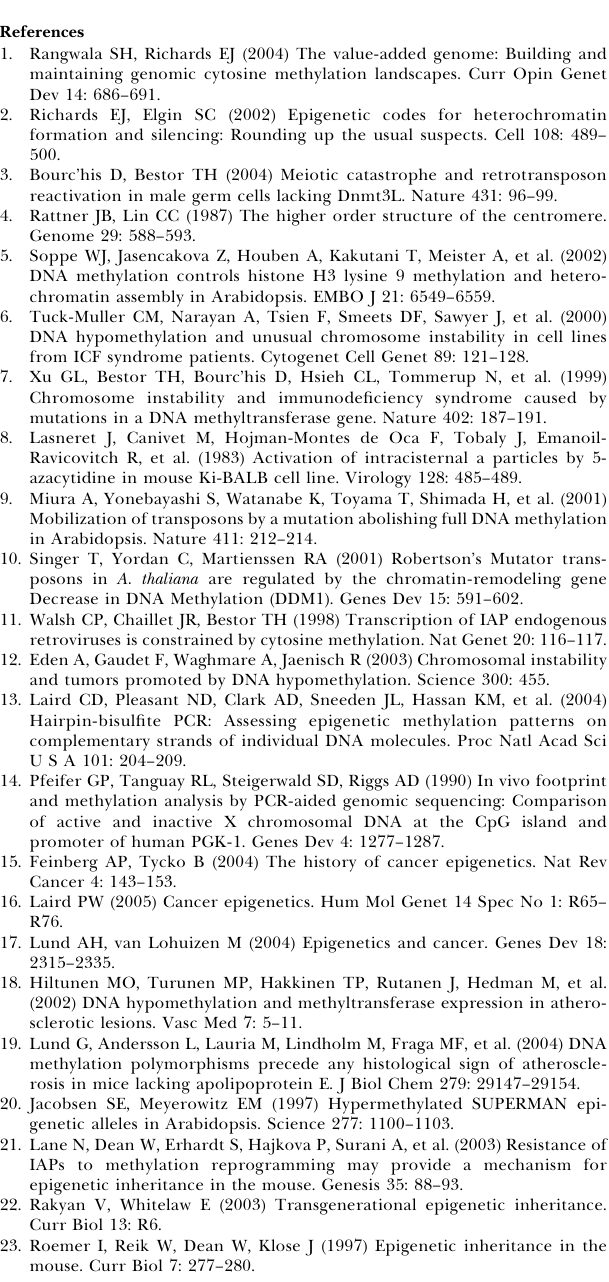
Figure S3. Map Position of 14 Full-Length (Red) and 25 Partial (Blue) Sadhu Elements on the Five Chromosomes of the A. thaliana Col Genome Partial elements are marked by their closest gene I.D. number. CEN ¼ position of physical centromere. Found at DOI: 10.1371/journal.pgen.0020036.sg003 (1.3 MB EPS). Table S1. List of Partial Sadhu Elements in the Col Genome Found at DOI: 10.1371/journal.pgen.0020036.st001 (54 KB DOC). Table S2. Primers Used in This Study Found at DOI: 10.1371/journal.pgen.0020036.st002 (47 KB DOC).